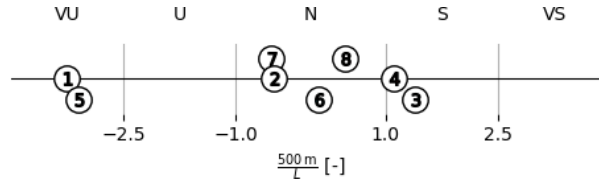
Figure 9. Obukhov lengths (plotted as 500m/ L ) found by fitting logarithmic profiles to the offshore cluster-mean wind profile shapes in Fig. 8. The stability classes are adopted from Table